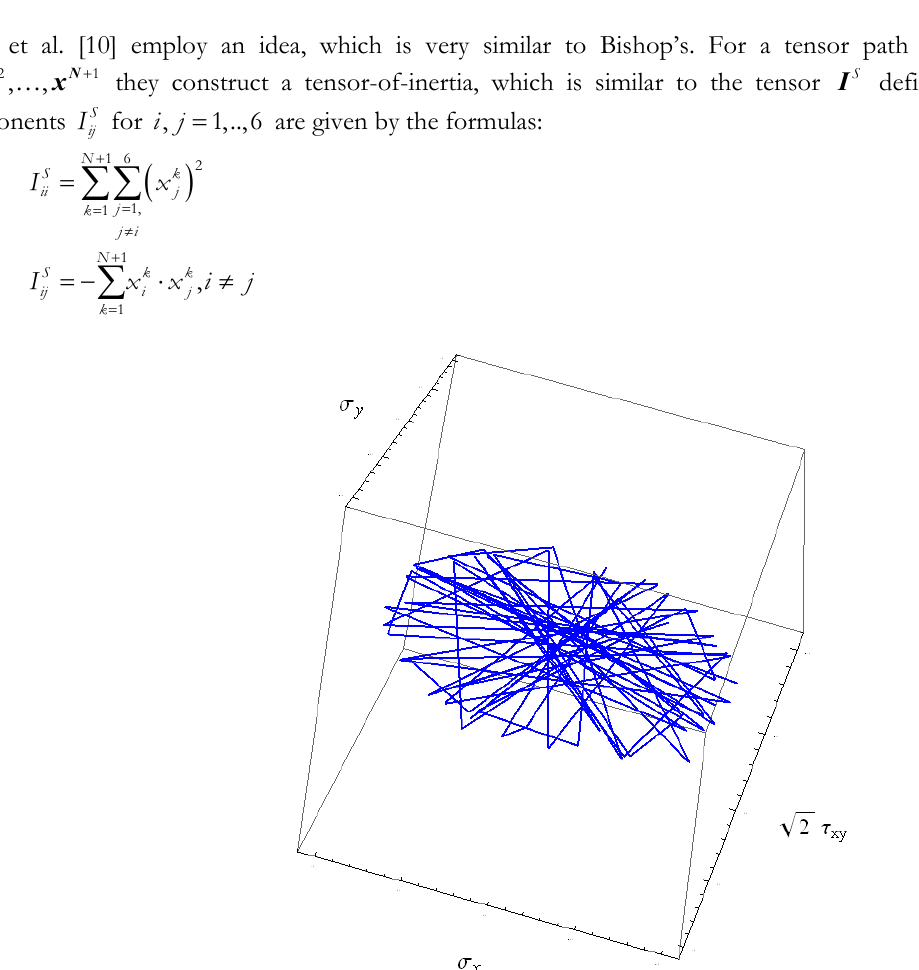
Figure 2: A non-proportional time-dependent tensor path (plane stress). Non-proportionality due to a narrow spike: 1,  m , 0  m d . 1 2